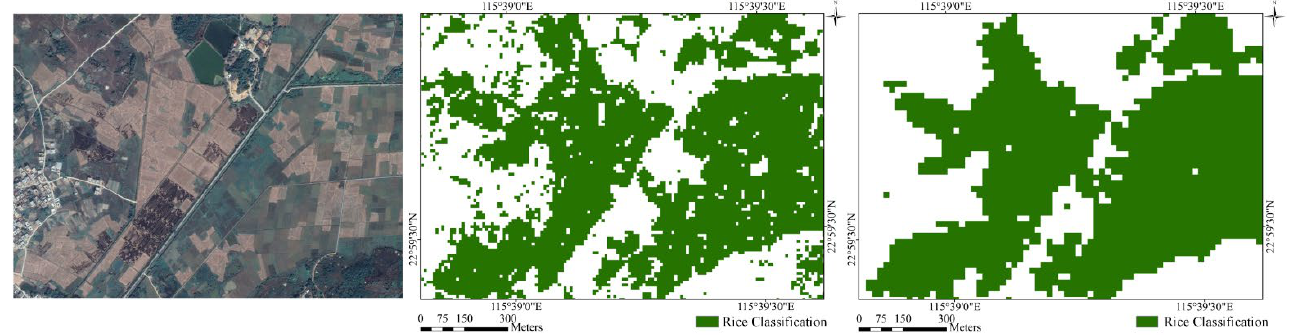
Figure 12. Comparison of rice maps. From left to right are the optical image, Pan et al.’s rice map and the proposed rice map,